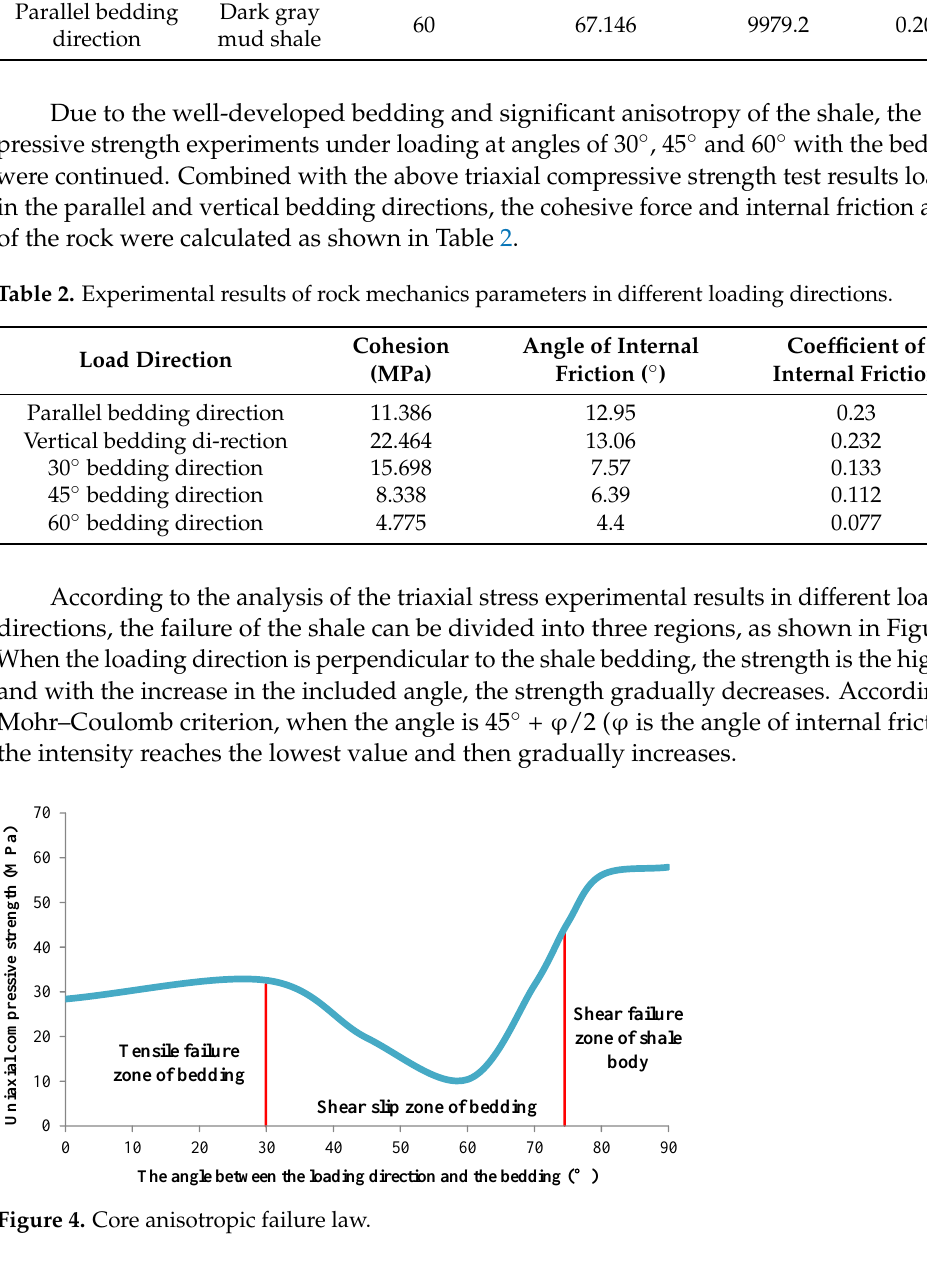
Table 2. Experimental results of rock mechanics parameters in different loading directions.